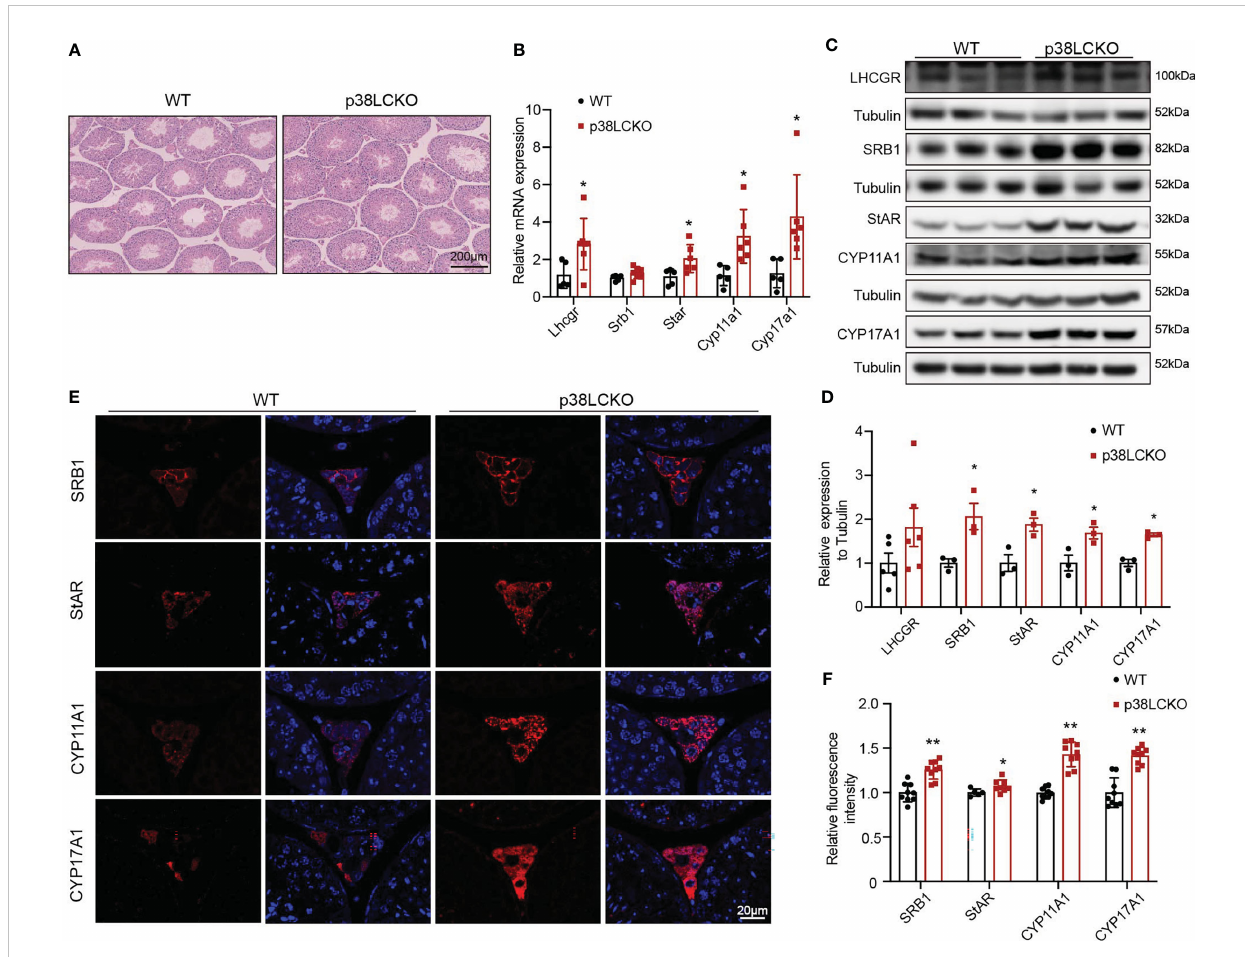
FIGURE 5 Assessment of ability of Leydig cell to produce testosterone in p38LCKO mice and WT mice at 18-month of age. (A) Testis morphology was examined by HE staining. (B) The mRNA levels of proteins related to were assessed by Q-PCR. (C) The protein levels of proteins associated with testosterone synthesis were analyzed by immunoblot. (D) Quantitative analysis for the protein level. (E) IF assessed the levels of testosterone synthesis-related proteins. (F) Quantitative analysis of fl uorescence intensity. *p<0.05,